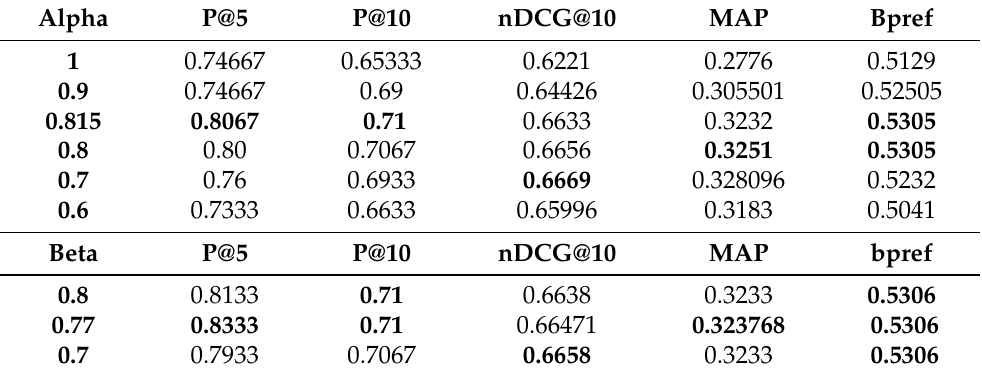
regulated by beta . In the first part of the table, results refer to SUBLIMER without reranker only neural model and BM25 Okapi, while in the second part, we analyze the reranker using the best alpha